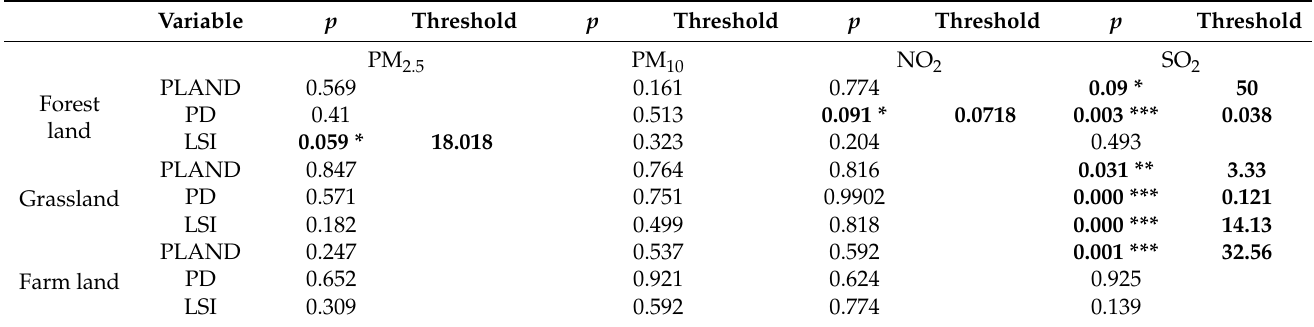
Table 1. Conclusion of thresholds for landscape pattern